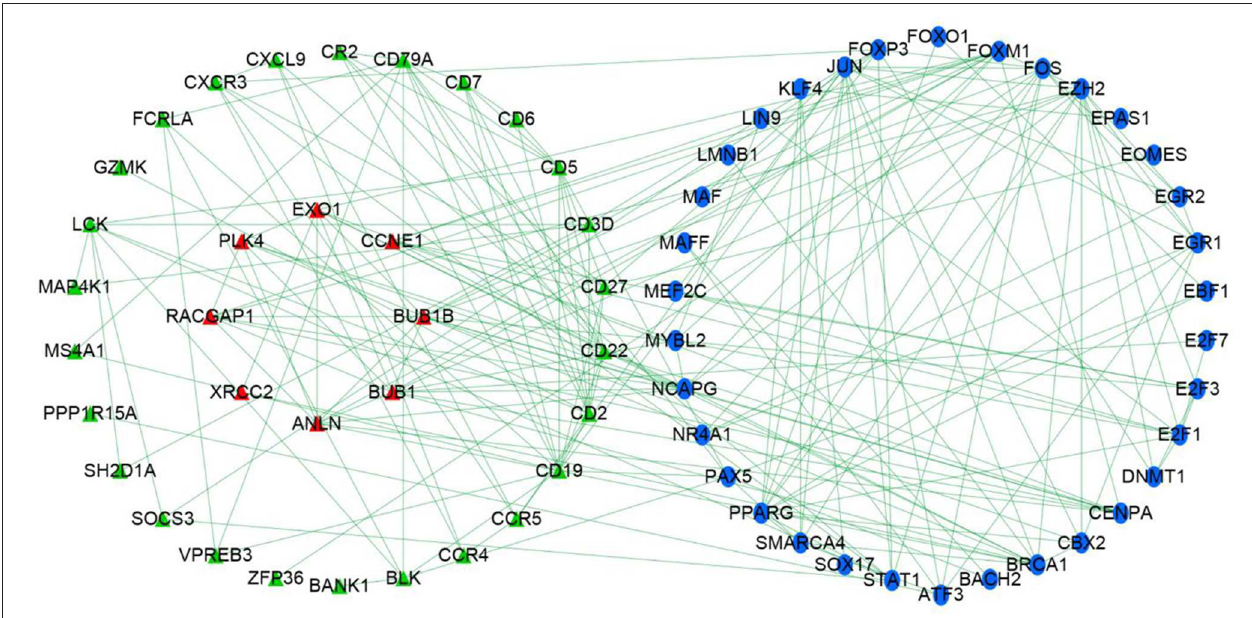
FIGURE 3 | Immune gene regulatory network chart.